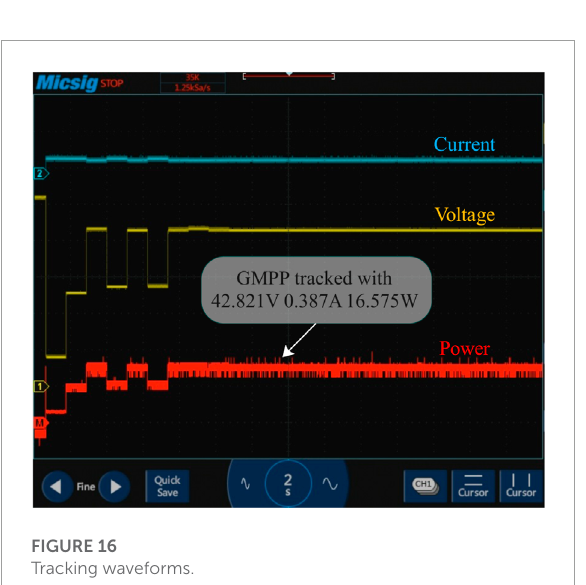
FIGURE 16 Tracking waveforms.